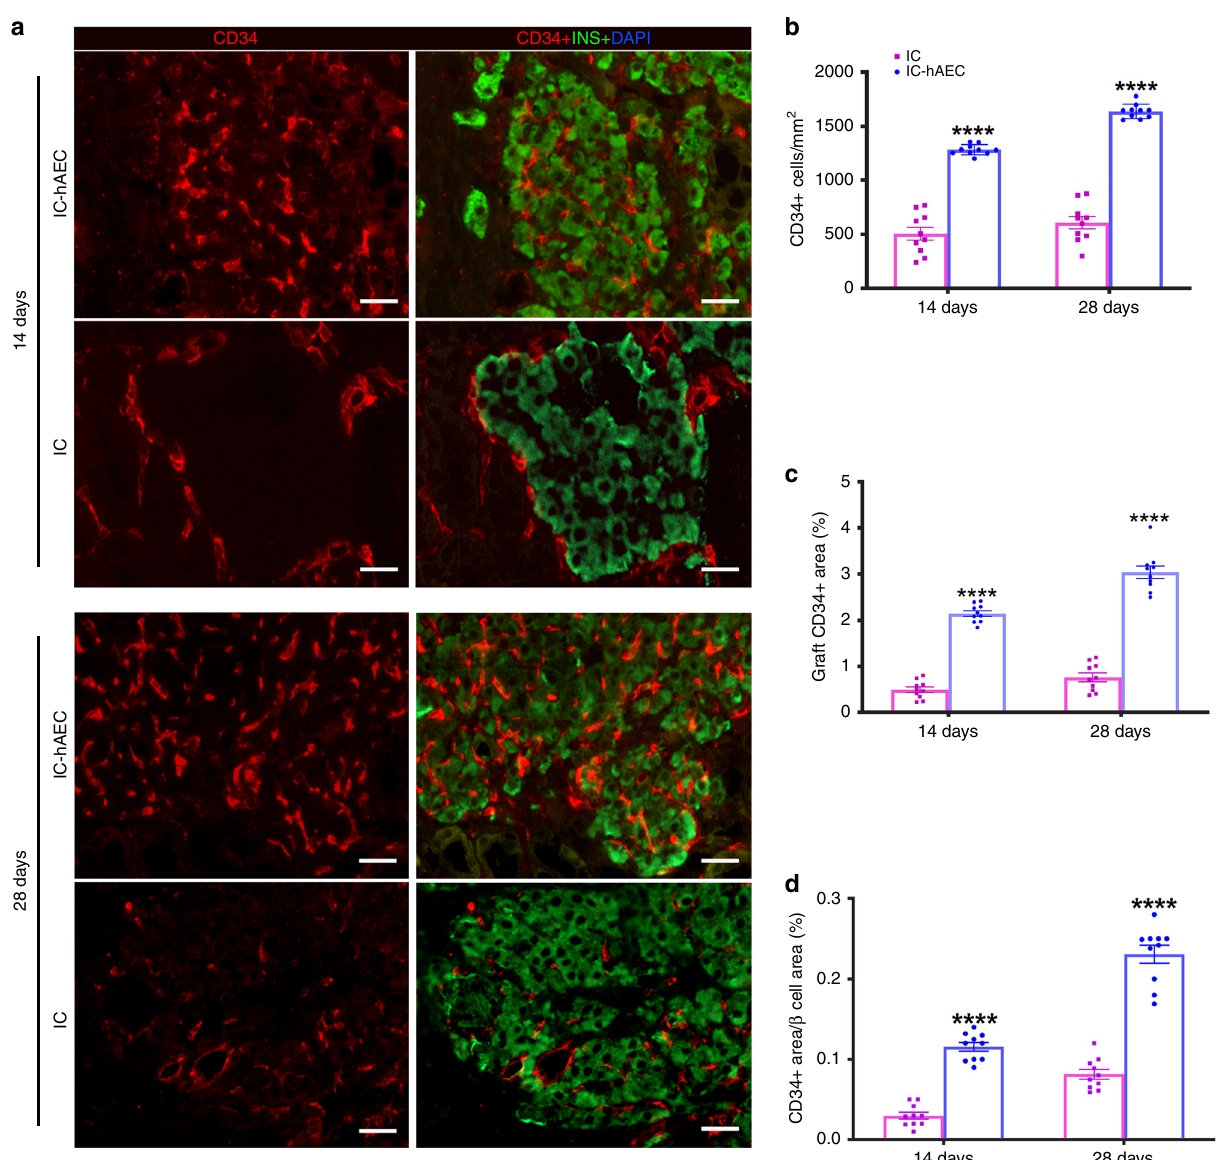
Fig. 6 Enhanced revascularization of the grafts in IC-hAEC group. a The blood vessels of the graft site were detected at day 14 and 28 using CD34 immunostaining. Scale bars = 20 μ m. b – d The total number of vessels was calculated as the number of endothelial cells per mm 2 of the graft. The vessel/ graft and vessel/ β -cell ratios were calculated as a percent of the graft and insulin-positive area respectively. **** p < 0.0001 vs IC group, two-way ANOVA, with Tukey ’ s multiple comparison test, n = 10. All data shown are mean ±